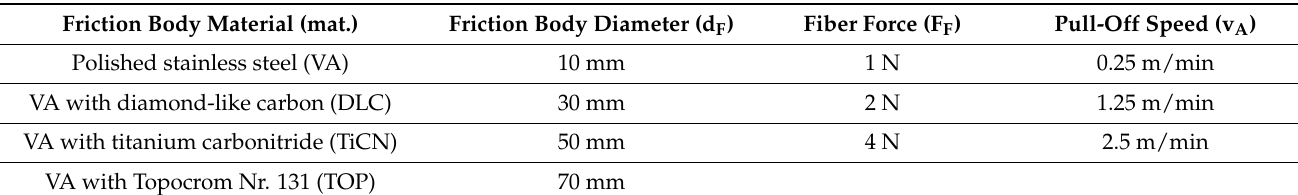
Table 3. Characteristics of the tribological